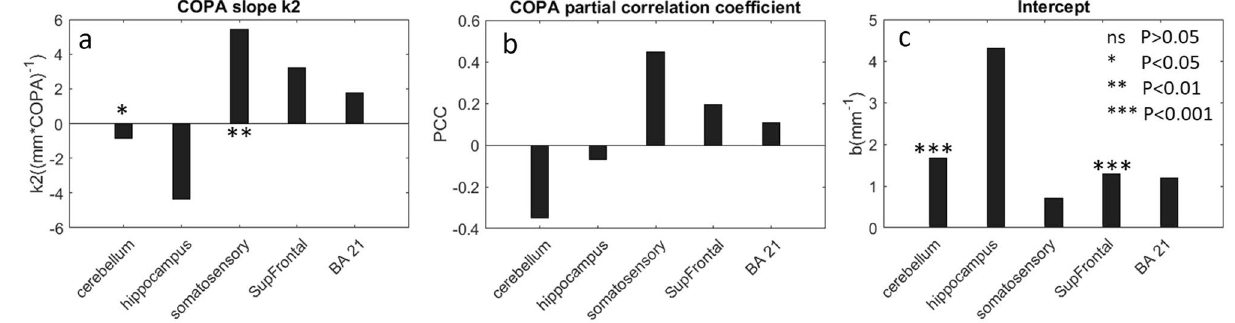
Figure 4. Evaluation of µ s with COPA and remaining factors in multivariate regression. (a) COPA slope k 2 in the five brain regions. Regions with stars indicate significant k 2 . (b) Partial correlation coefficient of COPA with respect to µ s . (c) Intercept b of the multivariate regression in the five brain regions.